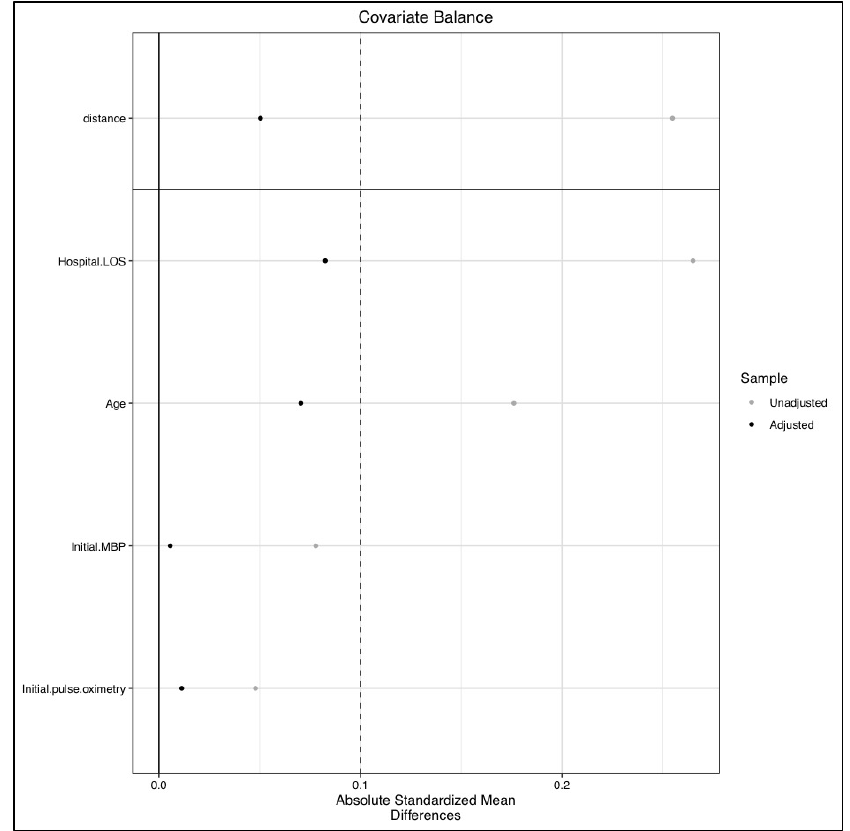
Figure 2. Absolute mean differences between patients with pre-hospital lactatemia > 4 mmol/L and those with pre-hospital lactatemia level < 4 mmol/L after matching. Legend: LOS: length of stay, MBP: mean blood pressure After adjustment on confounders, the association with 30-day mortality remains significant: ORa (95%CI) = 2.95 (1.14–9.18), p ≤ 10 − 3 ) for pre-hospital lactatemia > 4 mmol/L.